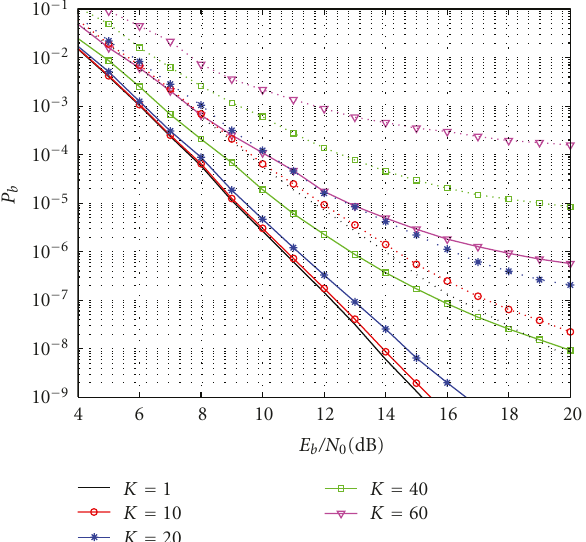
Figure 3: Performance of a convolutionally coded FHSS system over Nakagami fading with perfect CSI for di ff erent number of users K and SIR = 5dB, (solid: m = 1, dashed: m = 64).